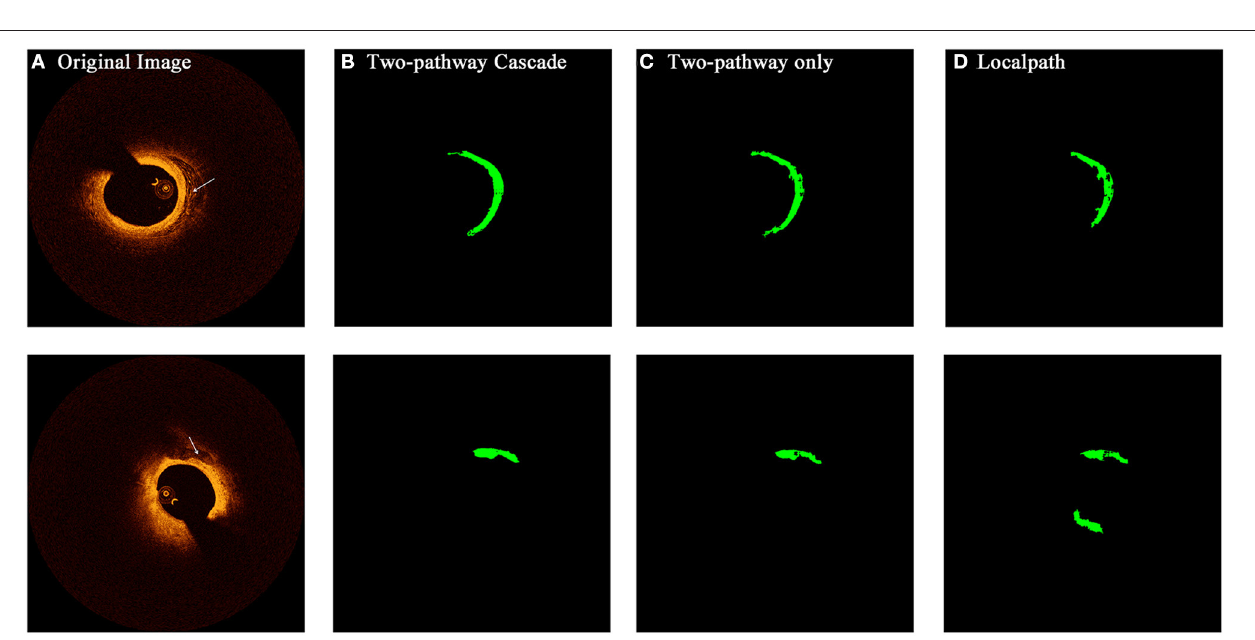
FIGURE 6 | The prediction results of OCT images with fibrous caps by different types of networks. Rows (A – D) show the initial OCT image, prediction by TwoPathCNN network with cascaded structure, prediction by TwoPathCNN only, and prediction by LocalPath, respectively. Different colors represent different plaque composition: blue: lipid, red: fibrous.